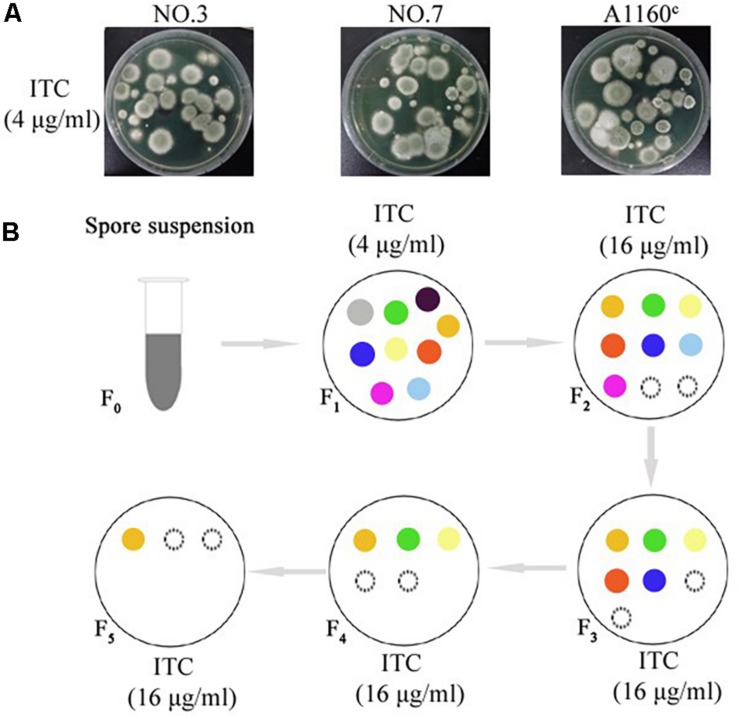
Induction of the adaptive strain. (A) 5 × 106 freshly harvested spores (5 × 106 spores/plate) from each parent strain were inoculated respectively on plates with 4 μg/ml itraconazole (ITC) at concentration that exert selection pressure for resistance to the drug at 37°C for 5 days. Different colony phenotype are shown on each plate. (B) The model of screening processes of the ITC-resistance strains. Extant lineages (F1 generation) under 4 μg/ml ITC were transferred into plates with 16 μg/ml ITC and incubated at 37°C for 5 days. Then, extant strains (F2 generation) on the 16 μg/ml ITC were continually transferred into next plates with 16 μg/ml ITC and incubated at 37°C for 5 days. Then, extant strains (F3 generation) were continually transferred into next plates with 16 μg/ml ITC, and so on. Extant lineages (F5 generation) on the plates with 16 μg/ml ITC were collected for further study. The colored circles represent different colonies. The black dotted line circles represent strains that show no signs of growth.